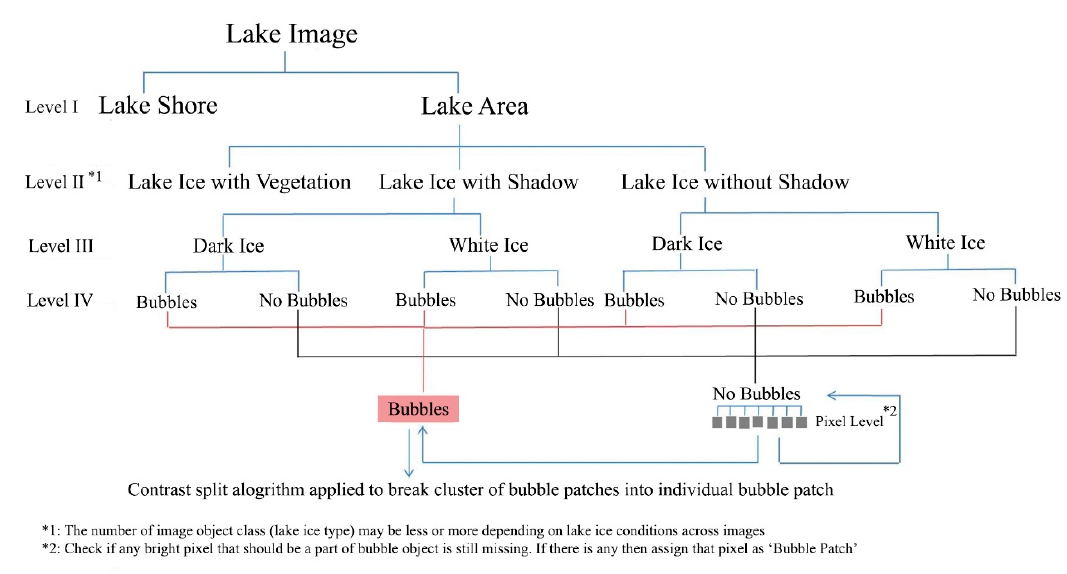
Figure 3. Image object hierarchy to identify ebullition bubble patches on early winter lake ice.